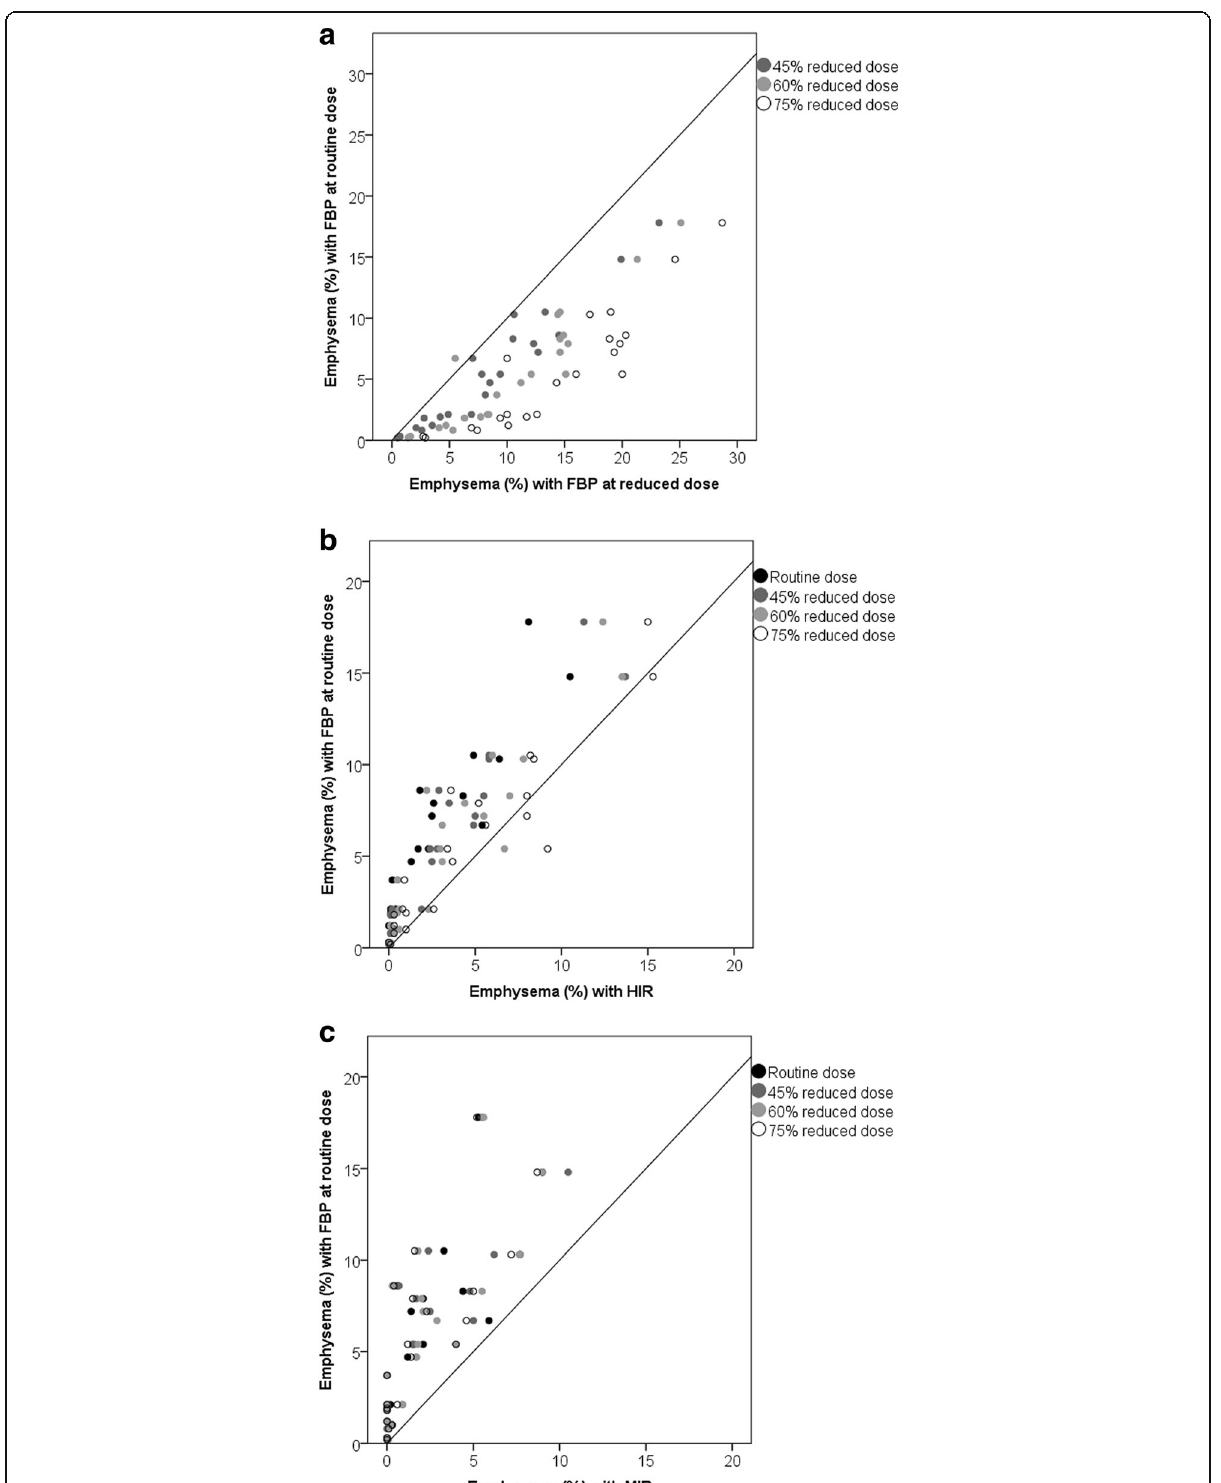
Fig. 2 Scatterplots of the effect of radiation dose and reconstruction on the percentage emphysema. The y-axis displays the percentage emphysema with FBP at routine dose (reference), while the x-axis displays the percentage emphysema at reduced dose with FPB ( a ) and with HIR ( b ) and MIR ( c ). Values below the diagonal represent an overestimation of the percentage of emphysema as compared to FBP and routine dose, while values above the diagonal represent an underestimation. FBP filtered back projection, HIR hybrid iterative reconstruction, MIR model-based iterative